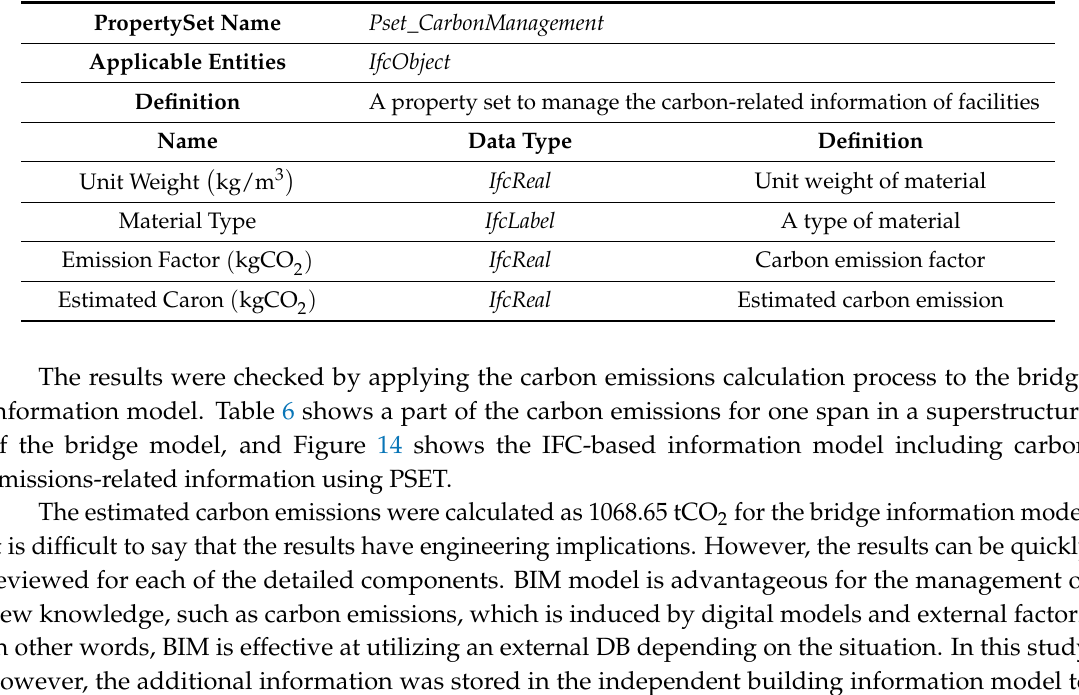
Table 5. User-defined PSET for managing the carbon related information.